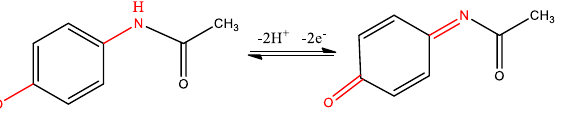
Scheme 1. Suggested AMP electrochemical mechanism at the surface of the exf-NGr/GCE- modified electrode.